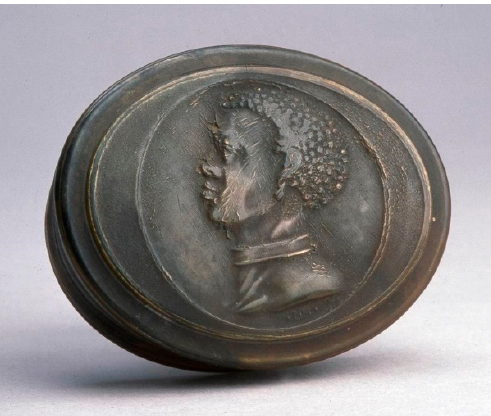
Figure 7. John Obrisset. Snuffbox or tobacco box, 8.10 × 10.20 cm (1889,0702.14). © The Trustees of the British Museum .